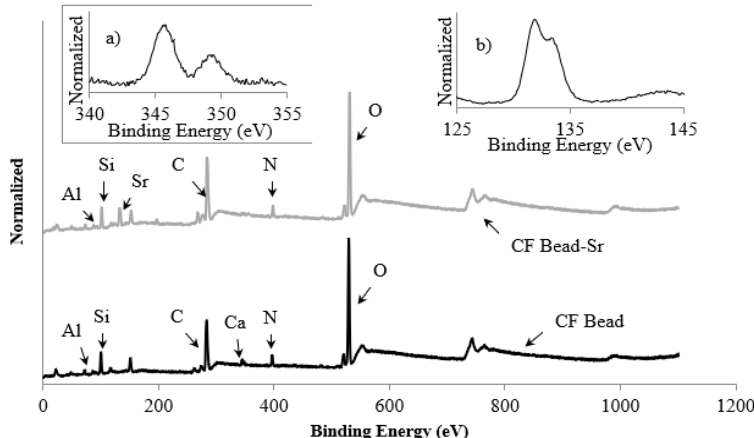
Figure 6. Survey scan of the CF bead exposed to strontium solution. Inset shows ( a ) calcium spectrum of the CF bead and ( b ) Sr-3d spectrum of the CF bead exposed to strontium solution. Healthcare 2019 , 6 , x FOR PEER REVIEW